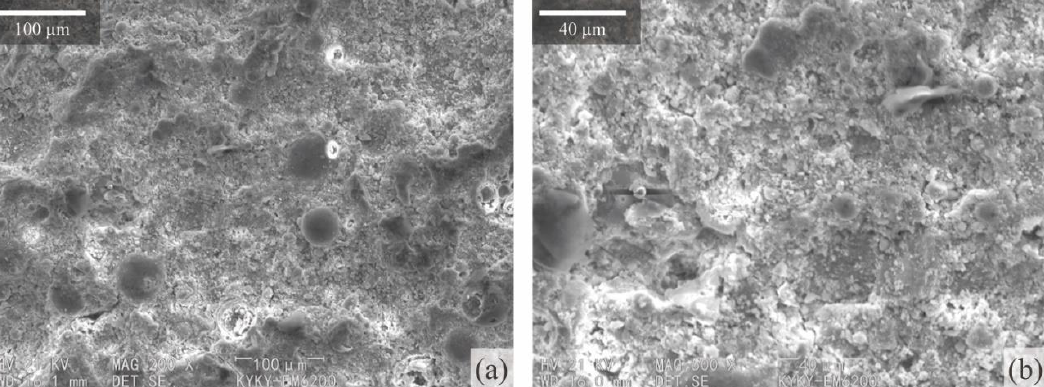
9 of 13 Figure 4. Dry shrinkage test change with time. ( a ) Cumulative water loss rate. ( b ) Cumulative strain. ( c ) Cumulative shrinkage factor. 3.5. Microscopic Test 3.5.1. SEM Analysis Figure 5a,b show the SEM images of 28 d slag/fly-ash-based geopolymer-stabilized macadam (GFA-4). It can be observed that the slag/fly-ash-based geopolymer produces many gelatinous substances with a dense and continuous irregularly shape, which significantly contributes the strength of slag/fly-ash-based geopolymer. Larger unbroken or incompletely broken spherical fly ash particles can be observed, which can decrease the